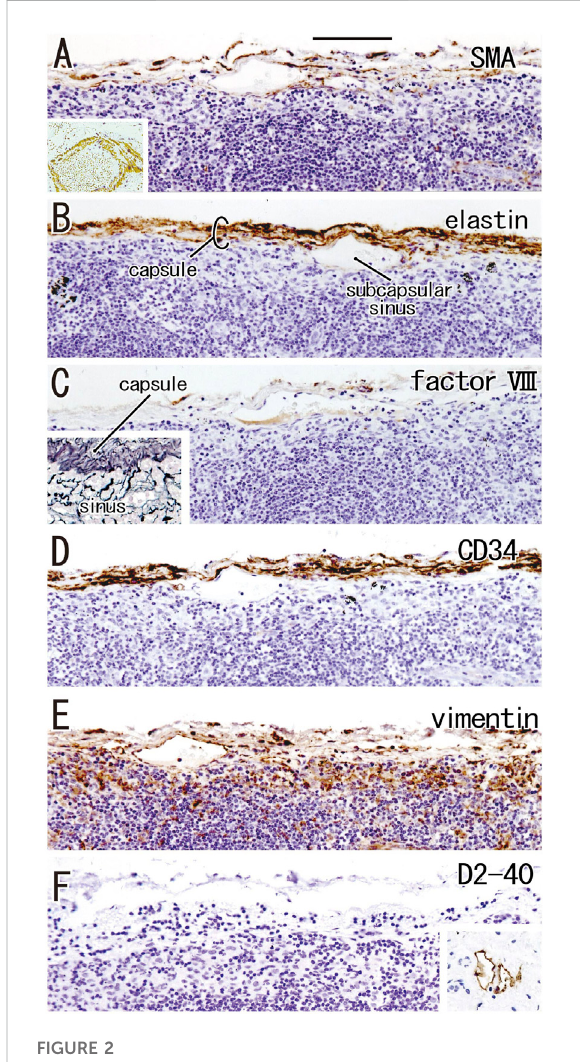
FIGURE 2 Immunohistochemistry of the lymph node capsule and subcapsular sinus: the usual morphologies. A subcarinal node removed from a 63-years-old woman (non-smoker). The DAB reaction made the positive cells brown. The nodal capsule expresses strong reactivity of elastin and CD34 (B,D) and it contains slender cells positive for immunostainings of smooth muscle actin (SMA) and vimentin (A,E) . An insert at the lower angle of (A) shows a positive control of the present SMA antibody (artery found in the same section). Few cells express factor VIII (C) . An insert at the lower angle of (C) displays silver staining of a near section containing violet colored thick fi bers in the capsule and blue-gray colored reticular fi bers in the subcapsular sinus. No reactivity is seen for D2-40 [podoplanin; (F) ] in contrast to